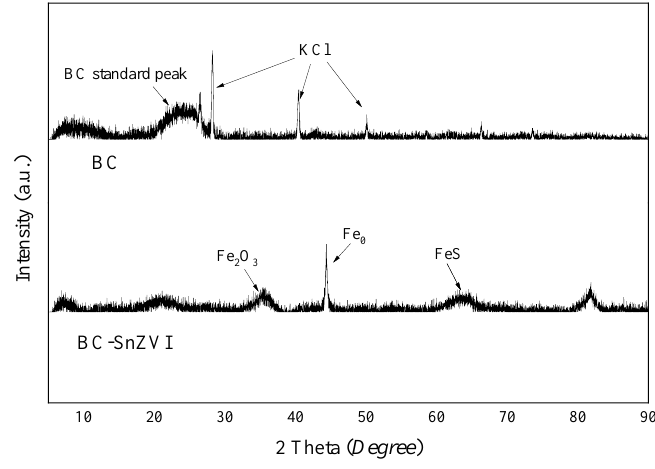
Figure 3. XRD patterns of BC and BC-SnZVI.